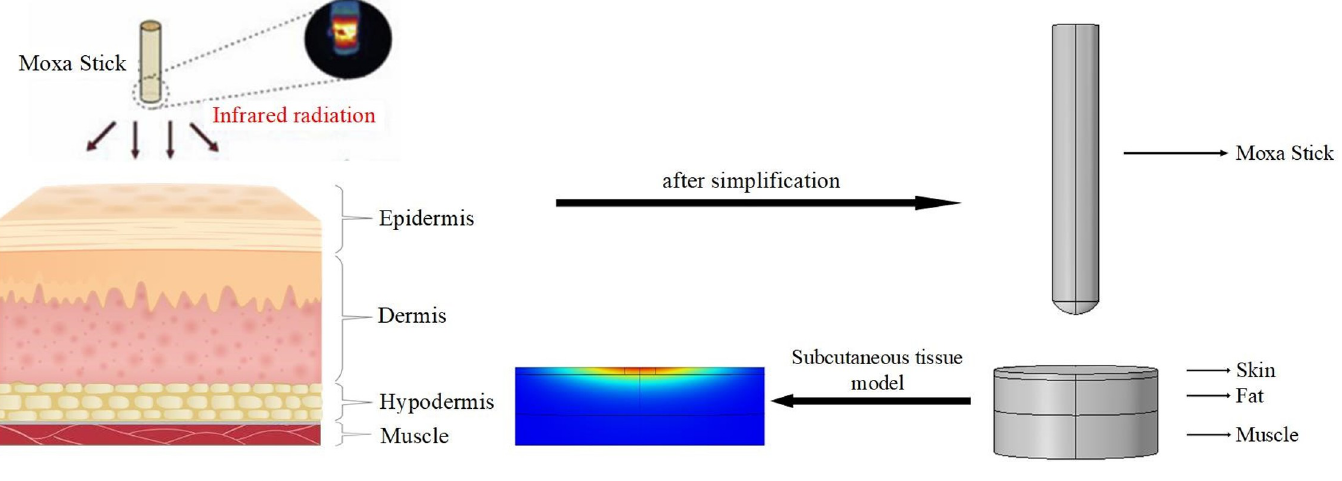
Fig 1. COMSOL simulation